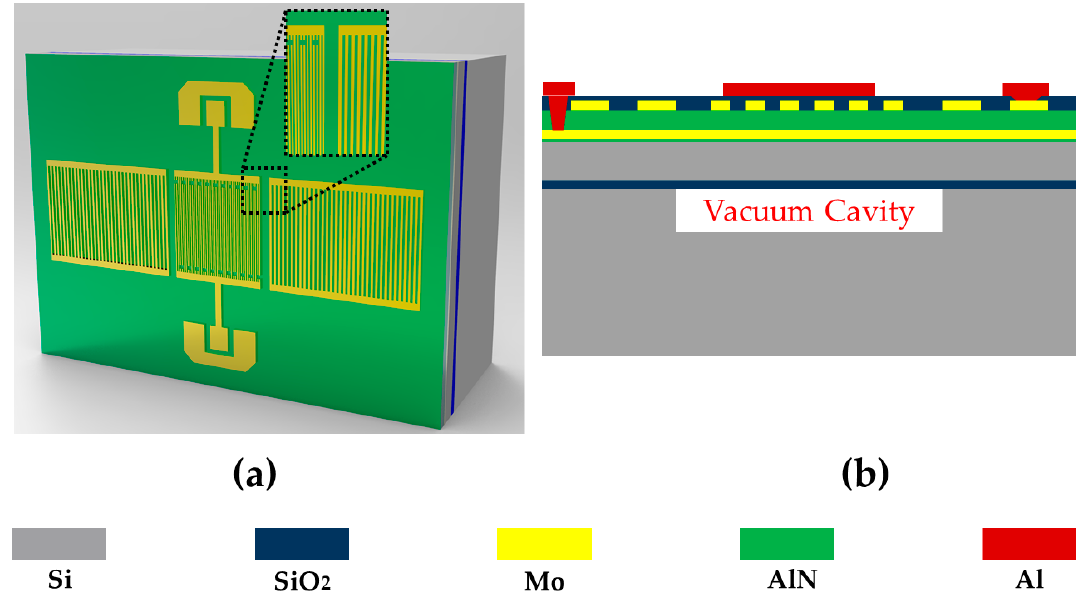
Figure 7. ( a ) The 3-D illustration of the acoustic wave pressure sensor; ( b ) cross-sectional view of the illustration.